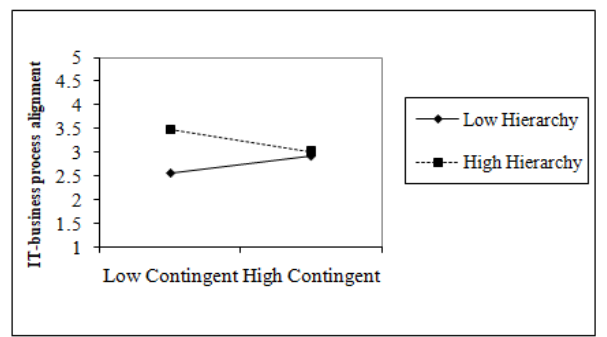
Figure 2. Contingent reward * hierarchy culture.